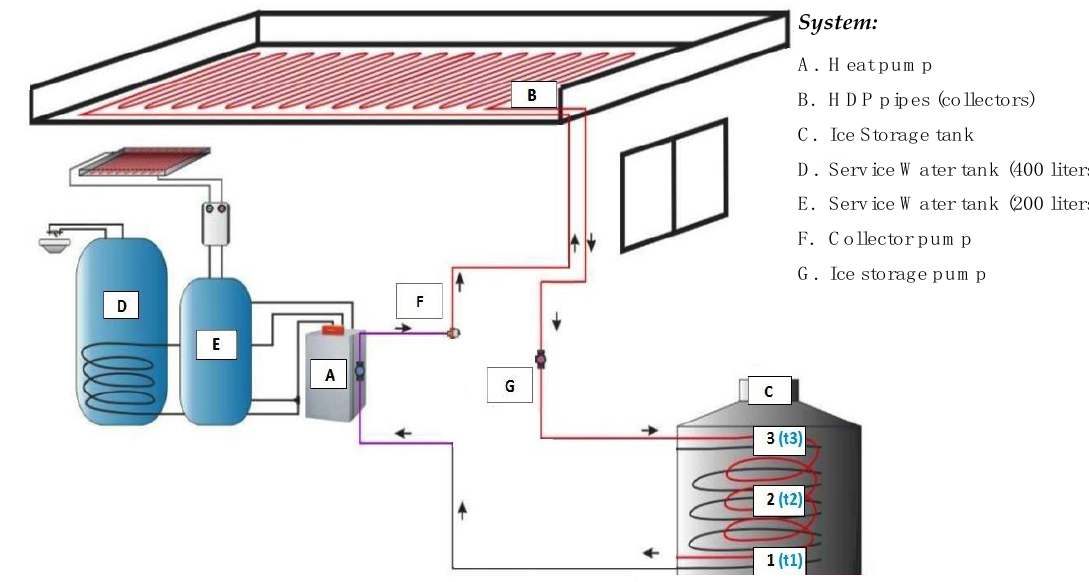
Figure 7. The second status of the heat pump.